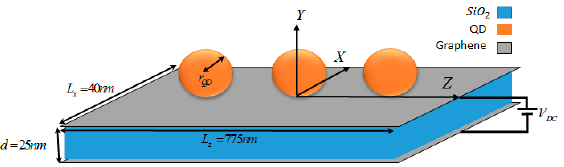
Figure 2. Schematic of Graphene-QD electrostatic gate structure.